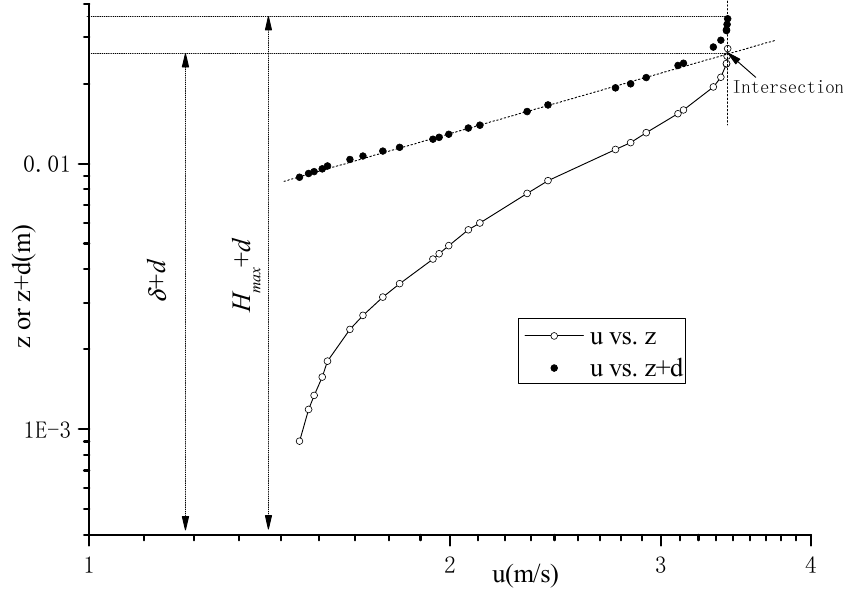
Figure 13. Schematic of the turbulence boundary layer thickness at the inception